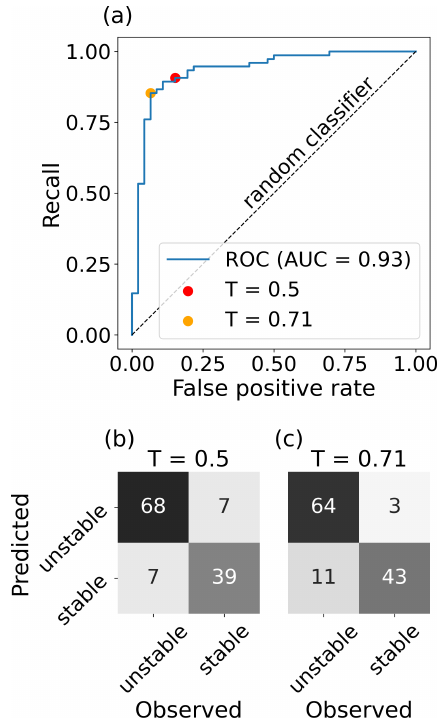
Figure 7. (a) ROC curve analysis and (b,c) contingency tables for the classification of the manually determined weak layers of the SWISS data set. Contingency tables are shown for (b) the default threshold ( T = 0 . 5) and (c) the optimized threshold ( T = 0 . 71) ob- tained from the ROC curve analysis.